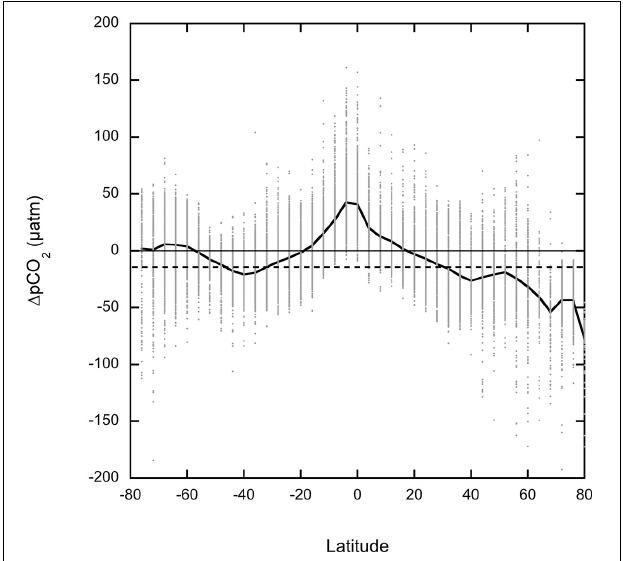
FIGURE 7 | Meridional cross section of the (cid:49) pCO 2 (=pCO 2w – pCO 2a ) climatology of Takahashi et al. (2014). The black line is the annual mean (cid:49) pCO 2 per 4 ◦ interval and the gray squares are the monthly averages for the 4 ◦ by 5 ◦ circumglobal grid boxes for the particular interval. Points above the solid horizontal line ( (cid:49) pCO 2 = 0) mean that the area is a CO 2 source to the atmosphere. The dashed line is the average disequilibrium needed for the global ocean to sequester 2.5 Pg C yr − 1